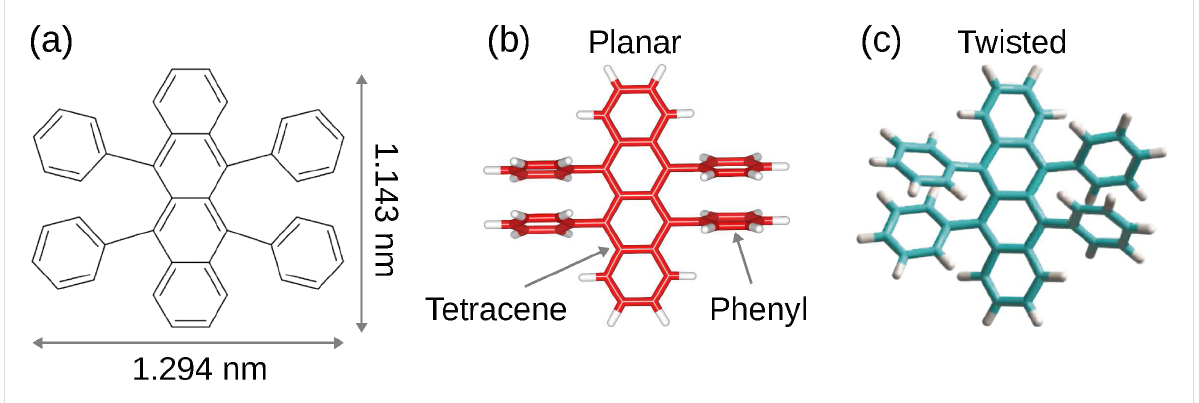
Figure 1: (a) Skeletal formula of C 42 H 28 including dimensions. (b) Sketch of the planar molecular configuration. (c) Sketch of the twisted molecular configuration. Adapted with permission from [22], copyright (2008) American Chemical Society.